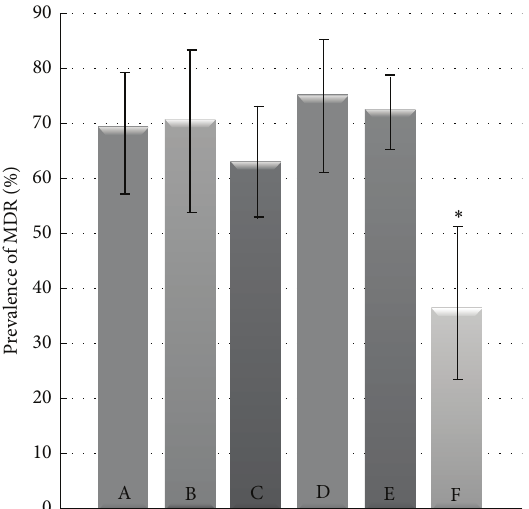
Figure 5: Percentage of MDR E. coli isolated from various types of infections in dogs and cats. A stands for skin and ear infections ( 𝑛 = 65 ), B soft tissue infections ( 𝑛 = 34 ), C gastrointestinal tract infections ( 𝑛 = 119 ), D respiratory tract infections ( n = 48), E urinary tract infections ( 𝑛 = 178 ), and F reproductive tract infections ( 𝑛 = 41 ). ∗ 𝑃 < 0.01